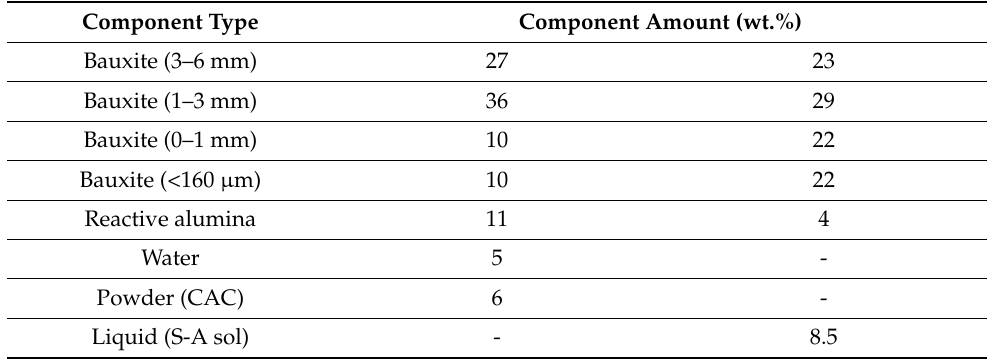
Table 1. Concrete mixture recipe with various types of binder (powdered (CAC) and liquid (S-A